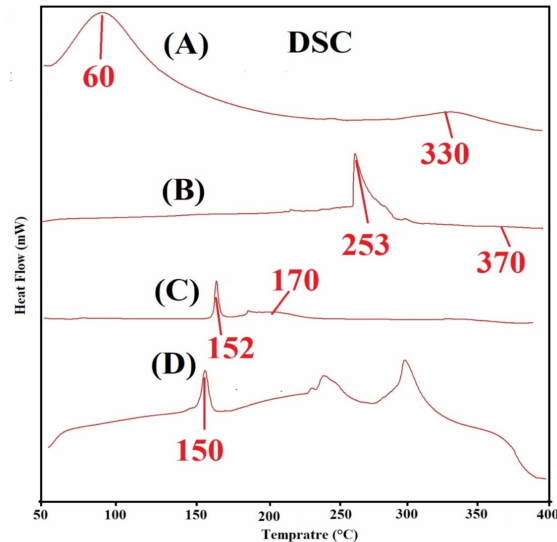
Figure 4. Differential Scanning Calorimetry ( DSC) of ( A ) SPS, ( B ) SPSPAA hydrogel, ( C ) KT, and ( D ) loaded SPSPAA